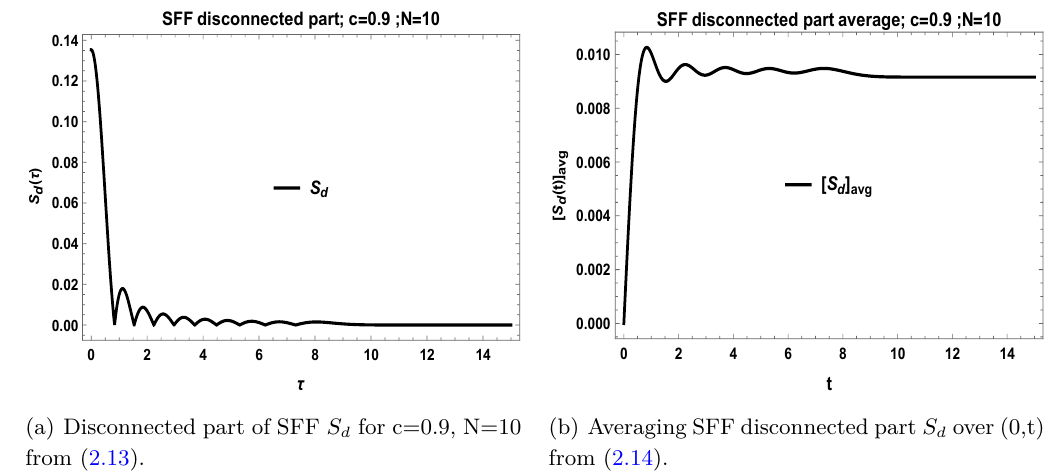
(b) Averaging SFF disconnected part S d over (0,t) from (2.14). Figure 1 . Spectral Form Factor disconnected part S d for two matrix model from eq.